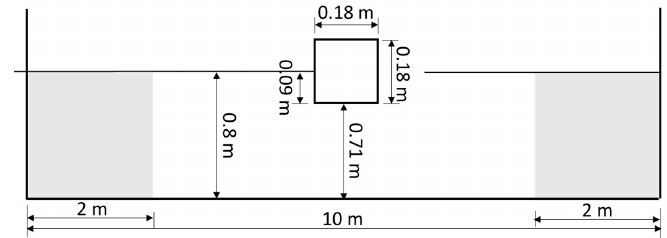
Figure 2. Illustration of the wave tank used in the decay test.